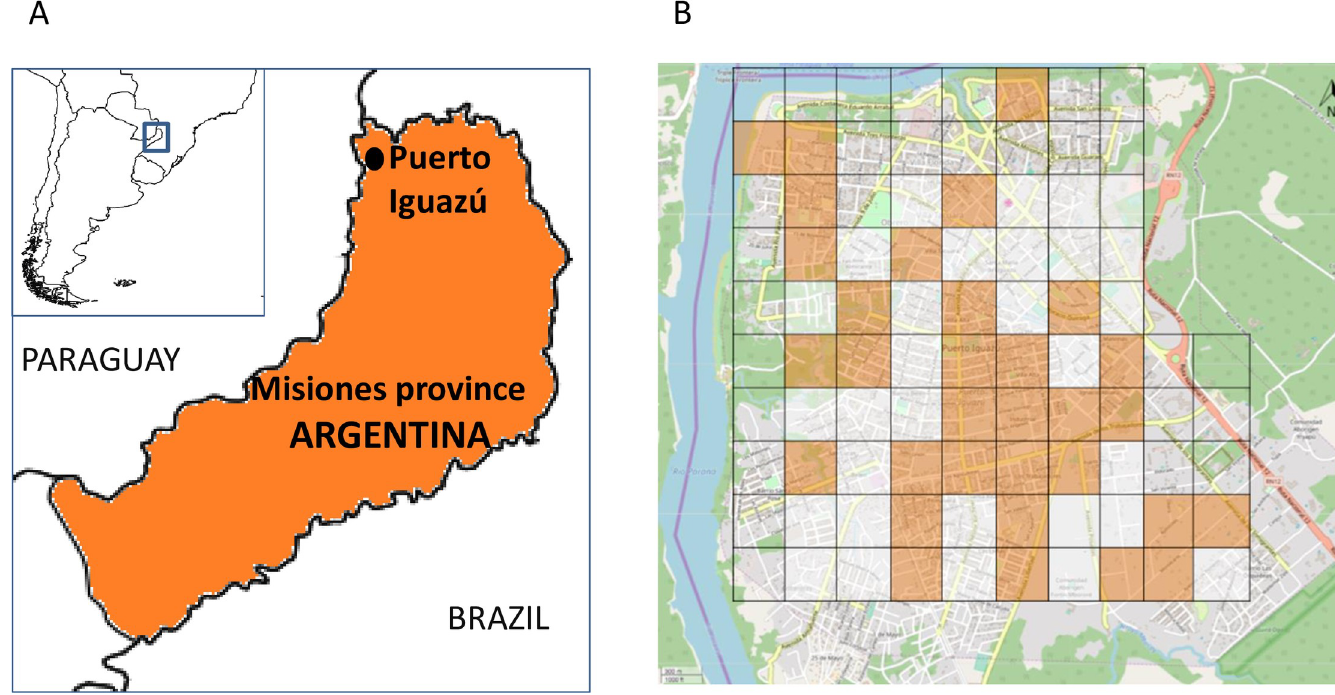
Fig 1. Study setting. A) Puerto Iguazu´, Misiones province, Argentina, in the border region with Brazil and Paraguay, B) Puerto Iguazu´ city; blocks in orange show the 32 selected study sites. Map sources: for Fig 1A, https://www.simplemappr.net/; for Fig 1B, https://www.openstreetmap.org/.